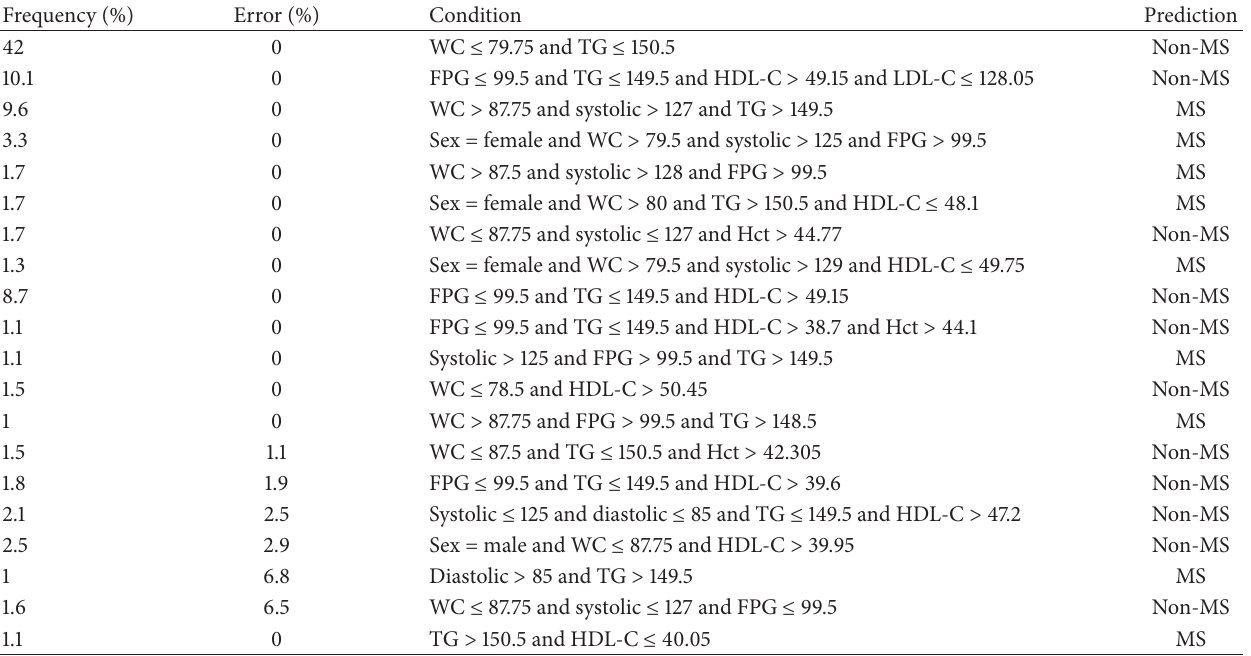
Table 5: Decision rules extracted from one of twenty trees from the predictive model trained with Random